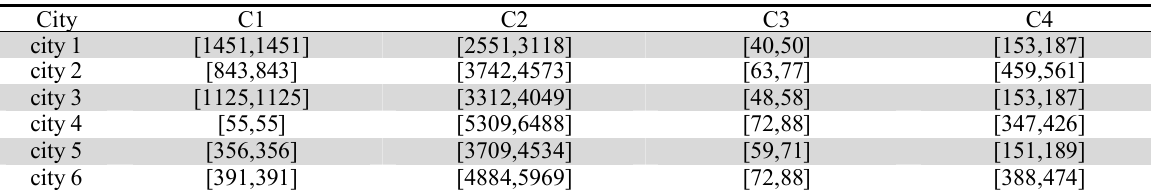
Data of alternative